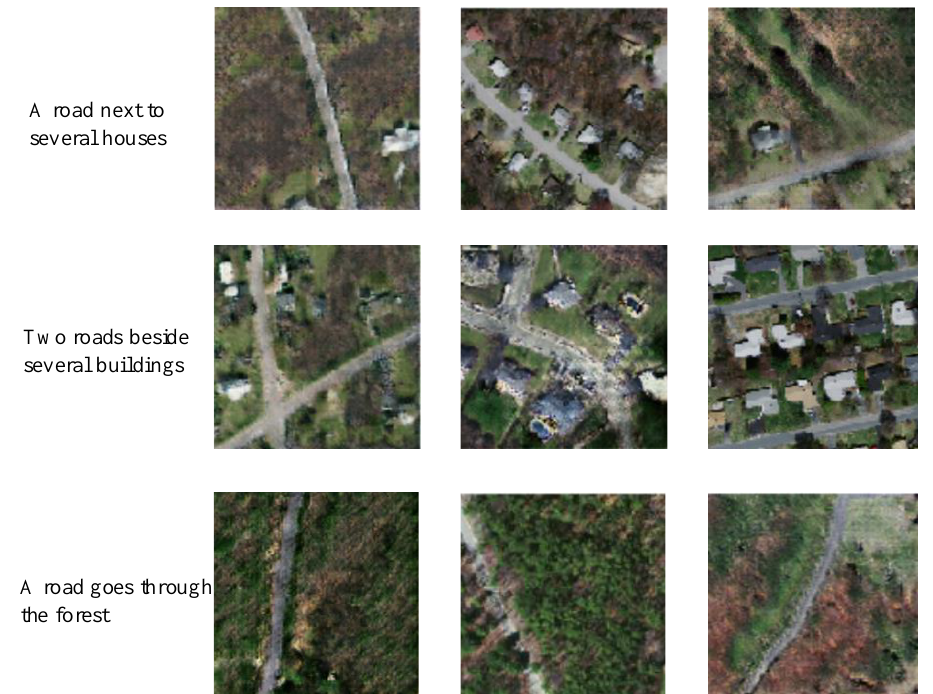
Figure 12. Generation results of BTD-sGAN on China remote sensing